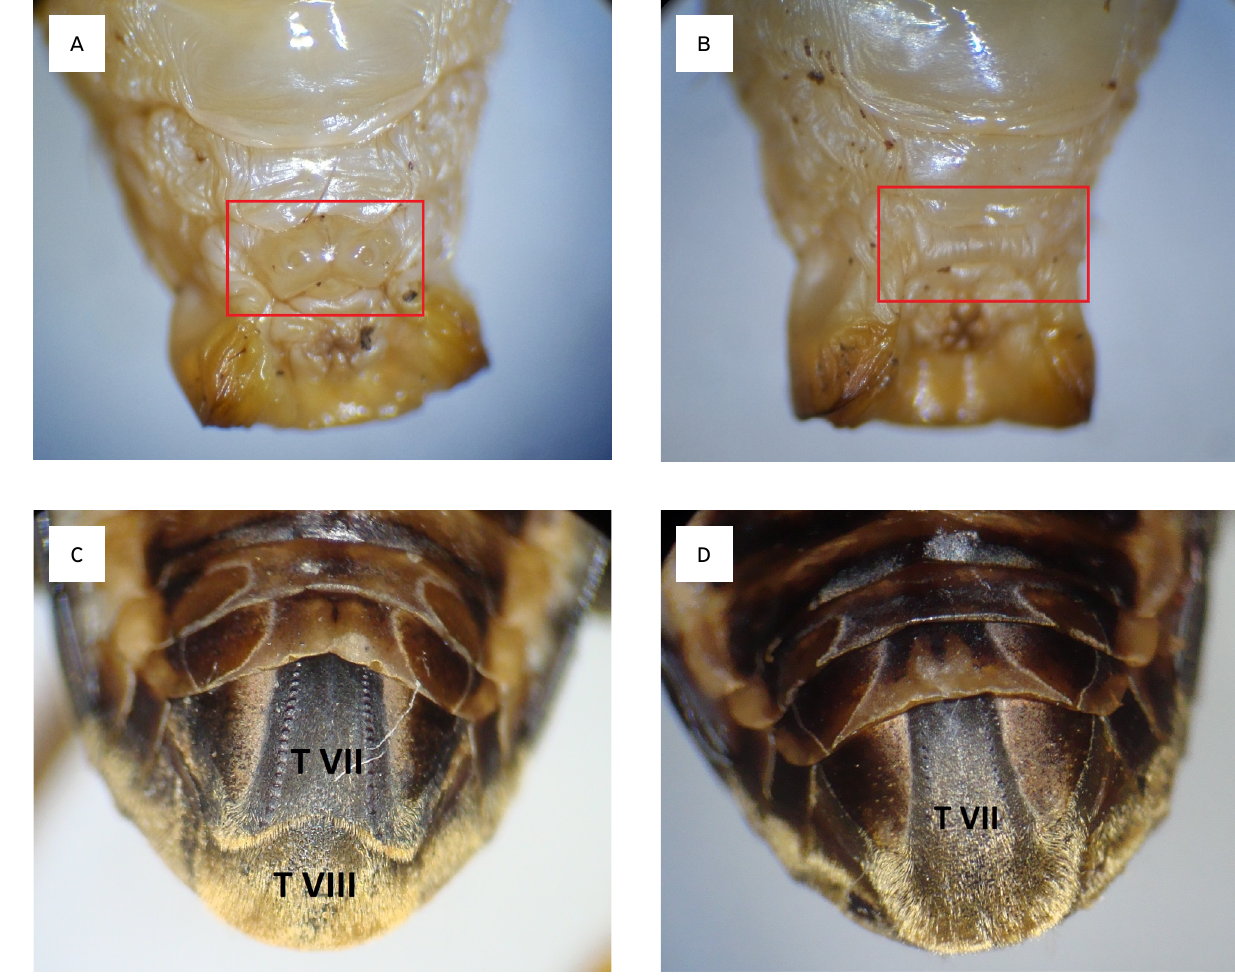
Figure 2. Sexual dimorphism in Ozopherus muricatus Pascoe, 1872 (Coleoptera: Curculionidae). (A) Protuberances in the terminal ventral region of female pupa; (B) absence of protuberances in the terminal ventral region of male pupa; (C) tergites VII and VIII visible on the abdominal dorsal region of adult male; (D) tergite VII covering tergite VIII in the abdominal dorsal region of adult